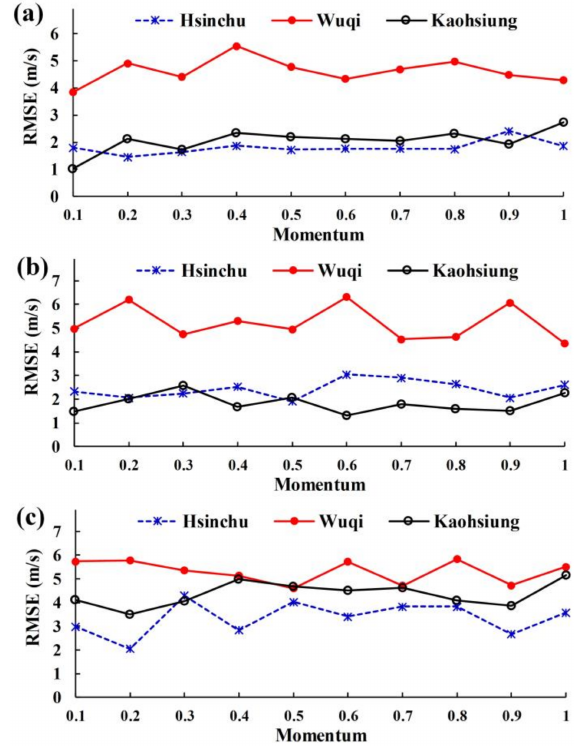
Figure 2. Sensitivity of artificial neural network (ANN) momentum for a 1-h lead forecast by typhoon path: ( a ) Type 2, ( b ) Type 3, and ( c ) Type